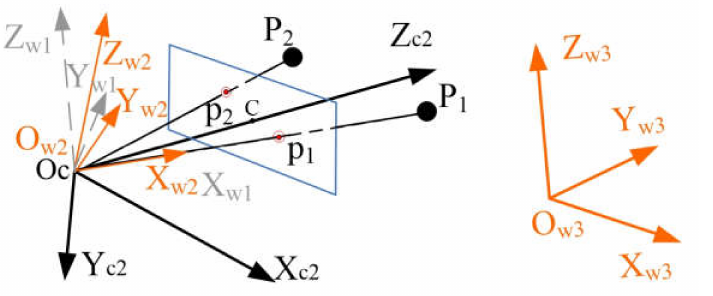
Figure 6. Two 2D–3D point correspondences in the final state. Now the absolute pose estimation is